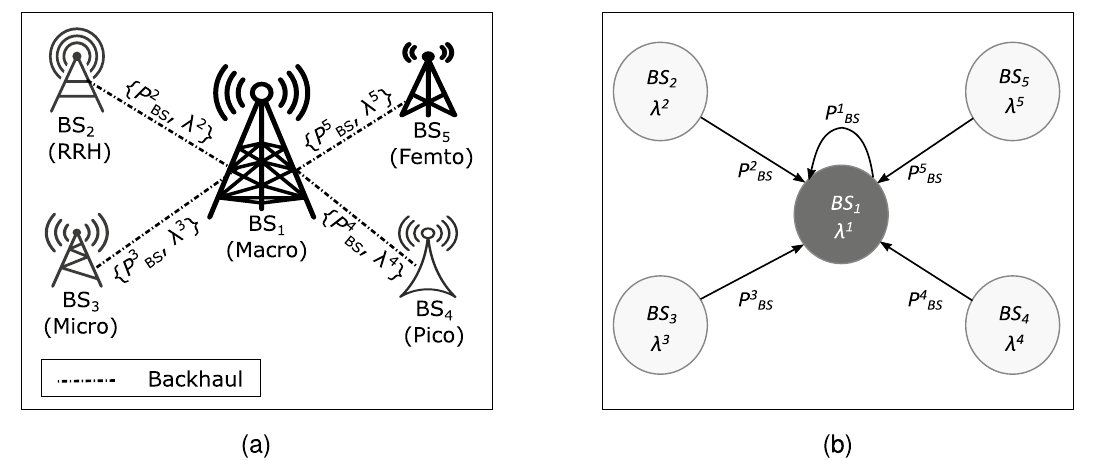
Figure 2. The proposed graph representation process ( a ) System model. ( b ) Graph representation model. Note that superscripts are for indexing purpose to match the notations in problem